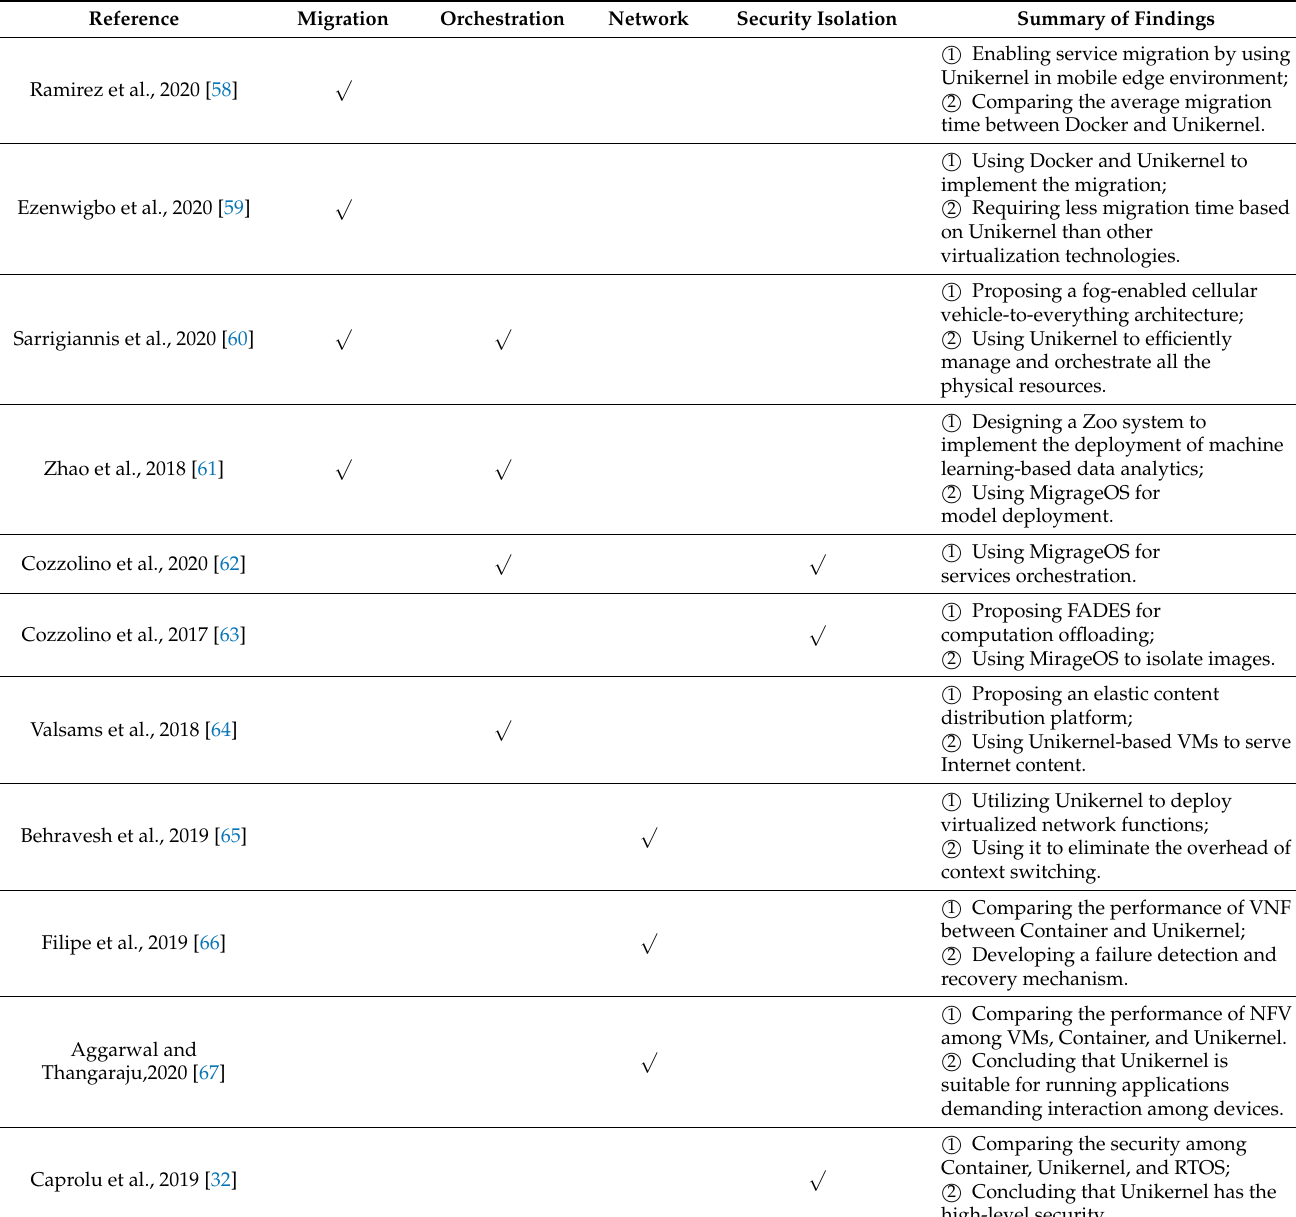
Table 4. Studies of Unikernel for different